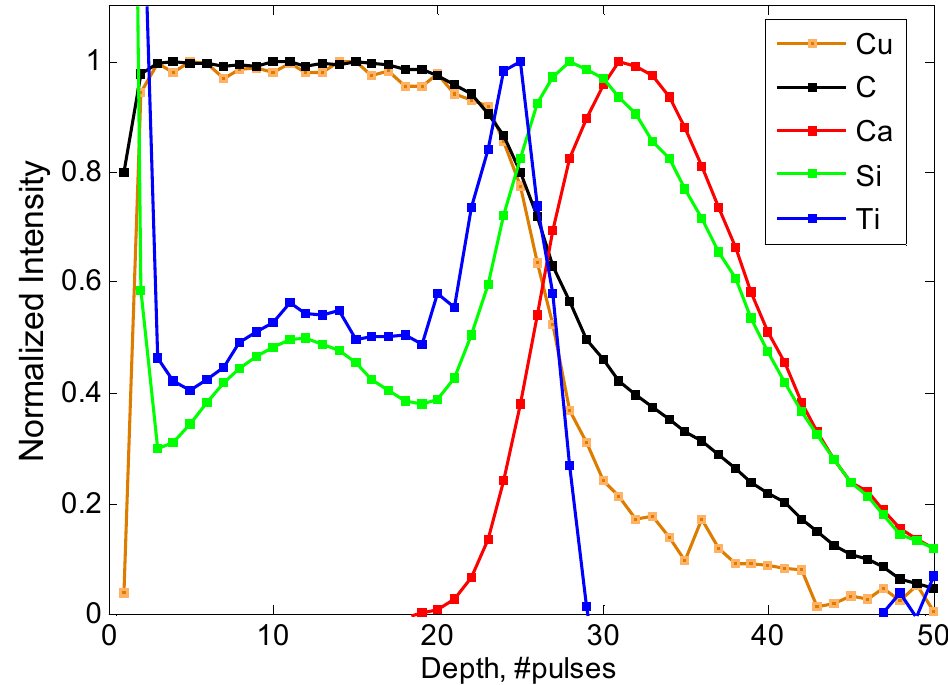
Figure 6. Normalized elemental concentration profiles of a toner print as a function of depth in a printed paper. Silicon and titanium exhibited very strong signals at the air–toner interface (not used in normalization) but the elements also accumulated in the toner–coating interface, as shown in the figure. Observe that the horizontal axis provides the mean of the number of laser pulses used to remove the toner.